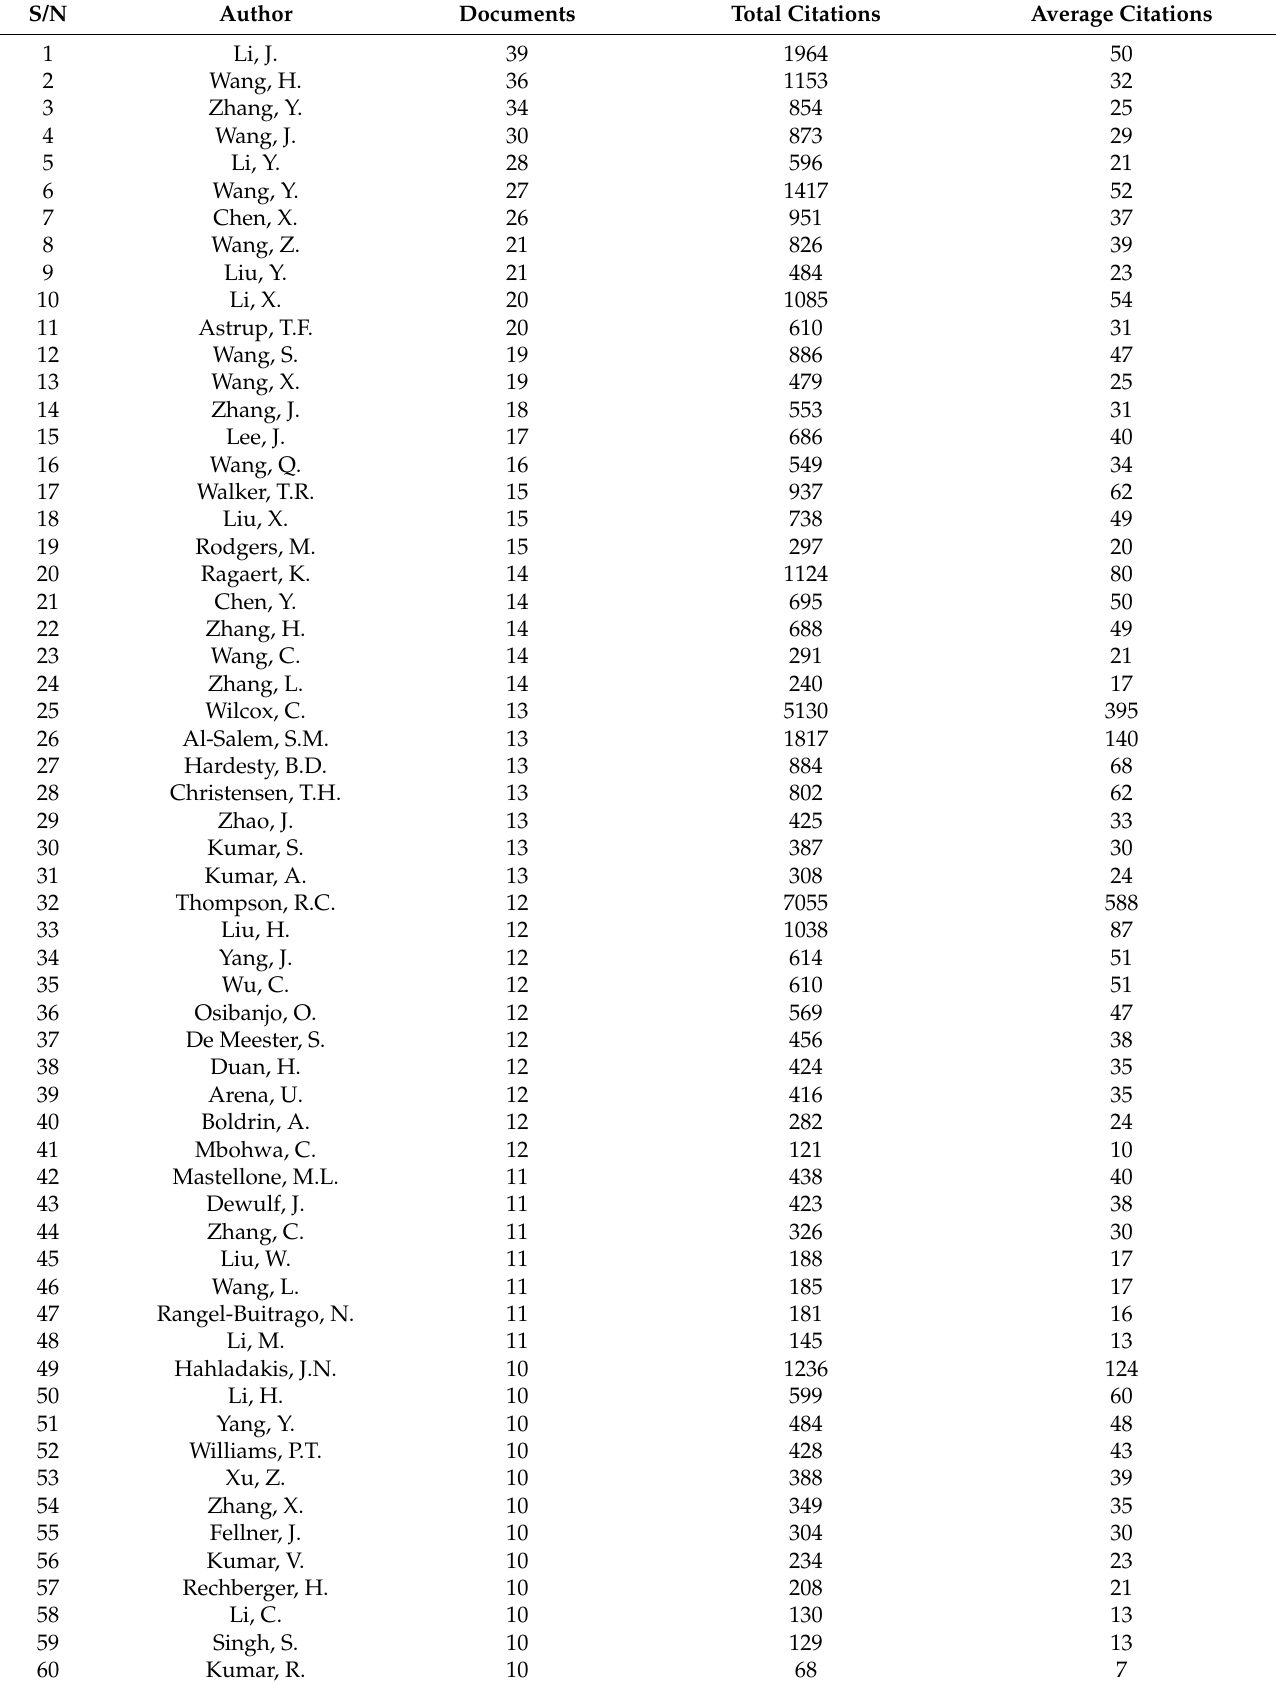
Table 3. Authors with at least 10 publications in the related study field up through